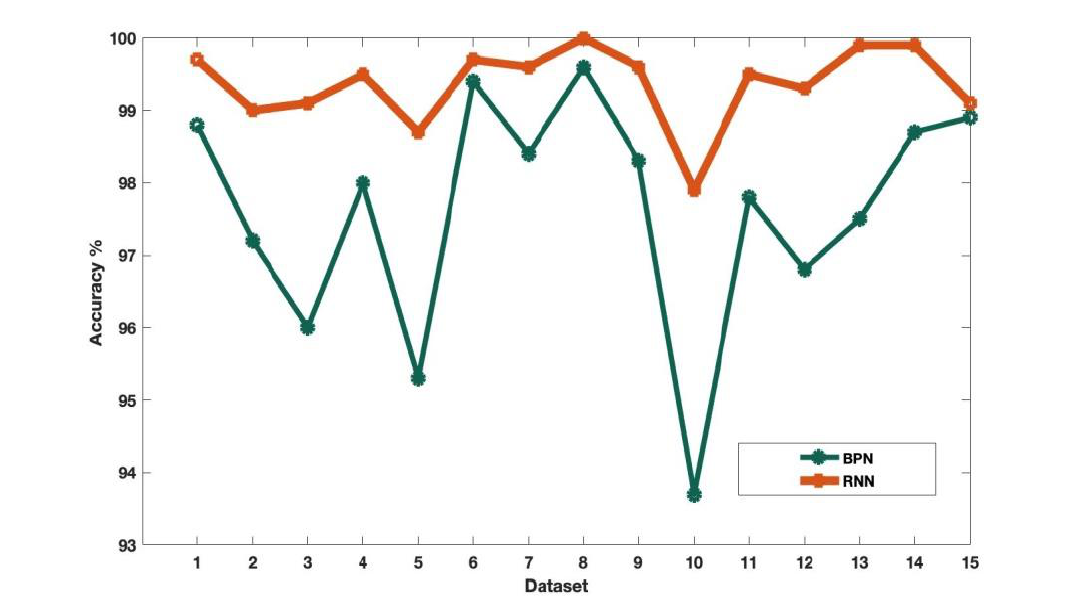
Figure 8: Classification Accuracy by BPN and